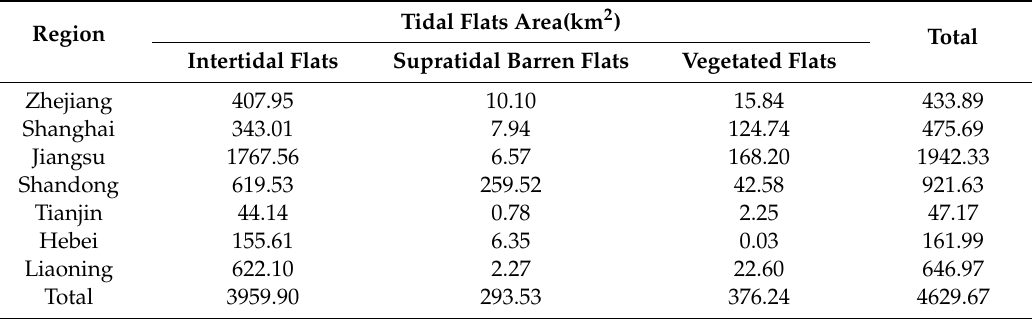
Table 3. Statistics table of three categories among tidal flats in terms of administrative divisions.